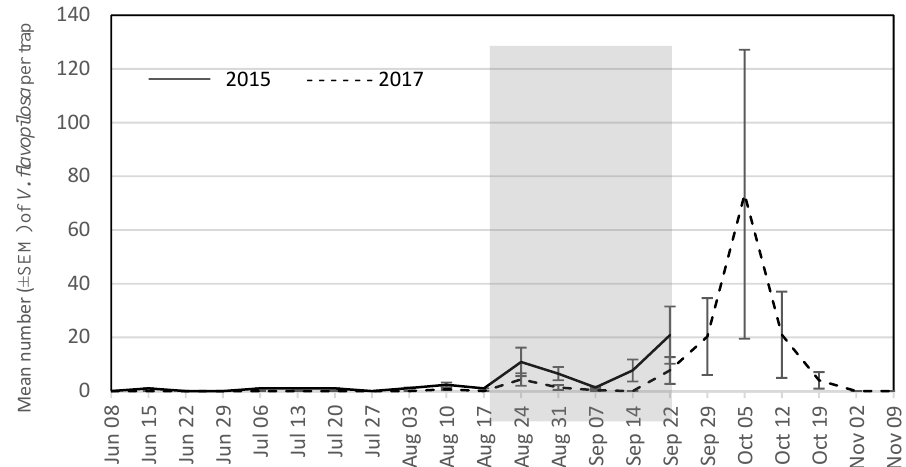
Figure 3. Mean number (±SEM) of Vespula flavopilosa caught per trap per week in South Central Wisconsin vineyards in traps baited with acetic acid and isobutanol (AAIB) from 8 June to 22 September 2015 (solid line) and from 8 June to 9 November 2017 (dashed line). The shaded region indicates the overall grape harvest for all grape cultivars present across all vineyards sampled.